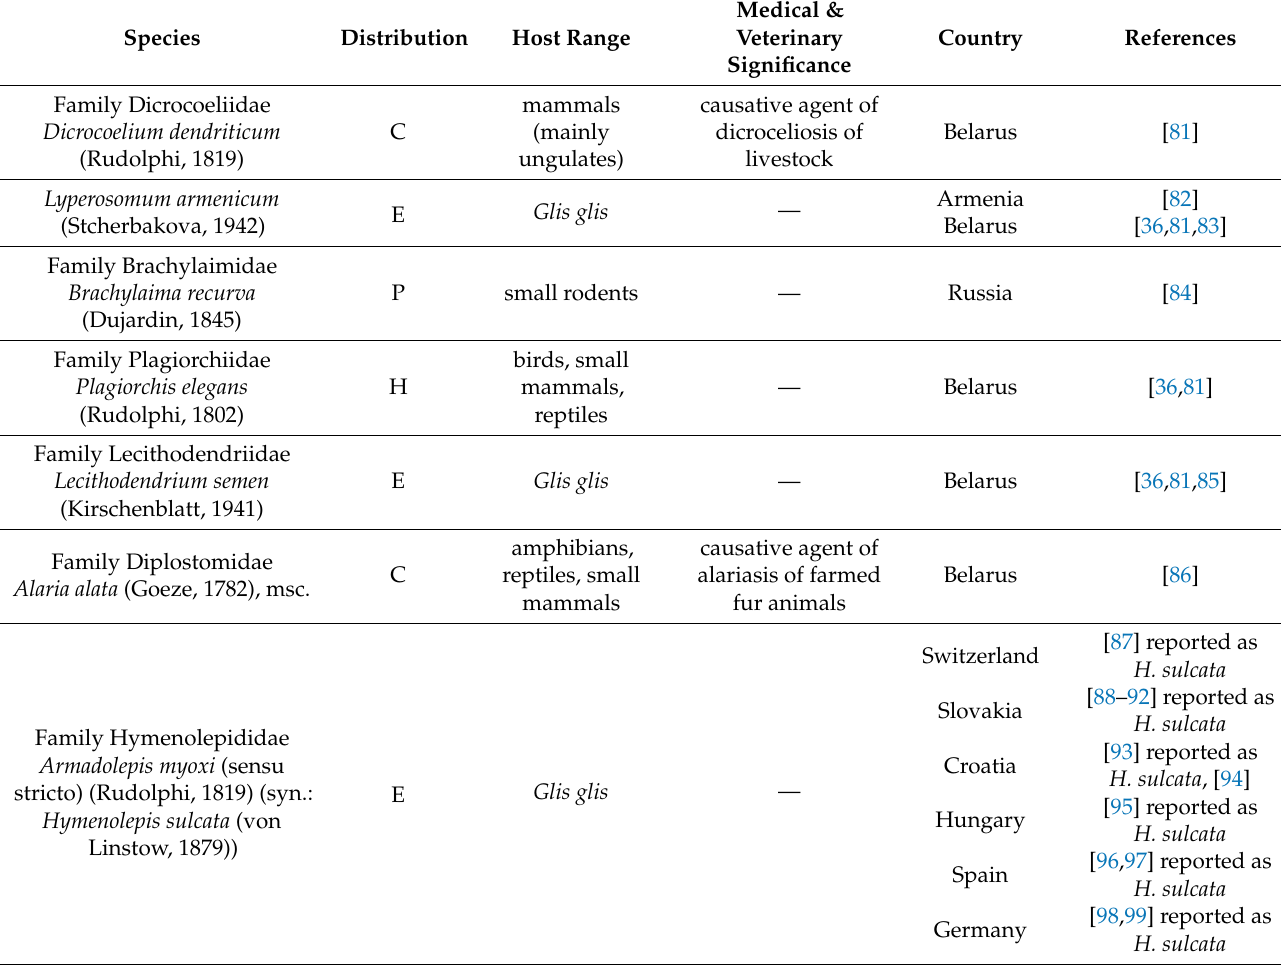
Table 3. Helminths of Glis glis in Western